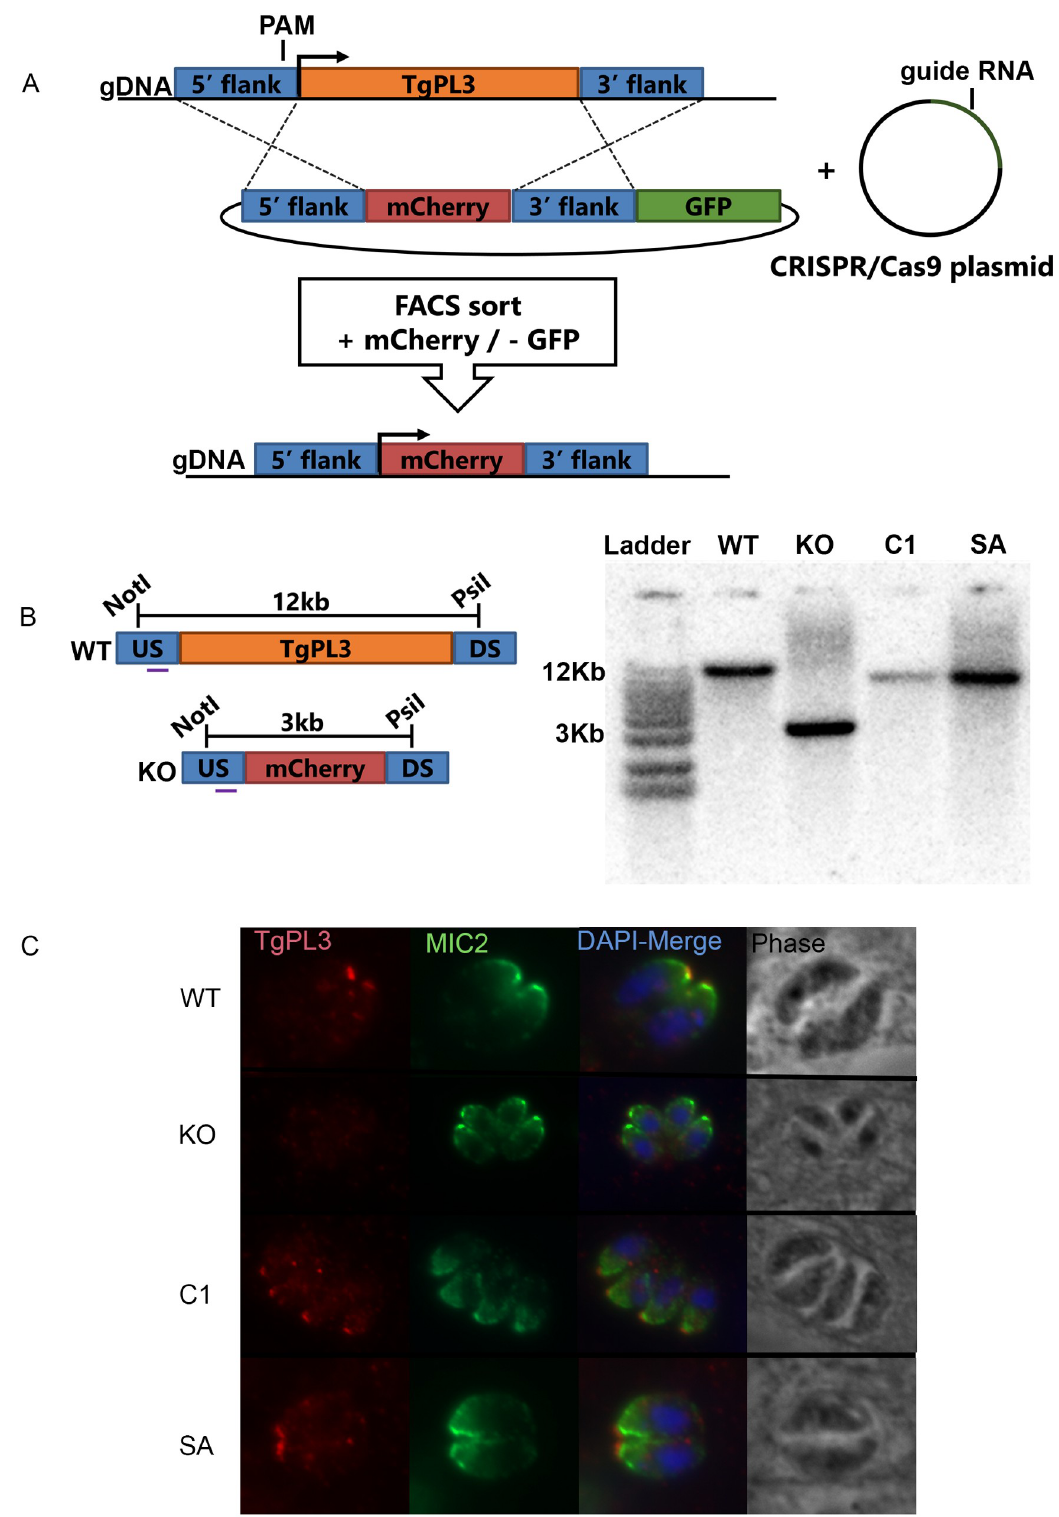
Fig 3. Deletion of TgPL3 from RH Δ Ku80 parasites using FACS sorting. (A) Schematic for the targeted knockout of the TgPL3 gene in T . gondii by double homologous crossover. Parental strain RH Δ ku80 Δ HXGPRT parasites were electroporated with